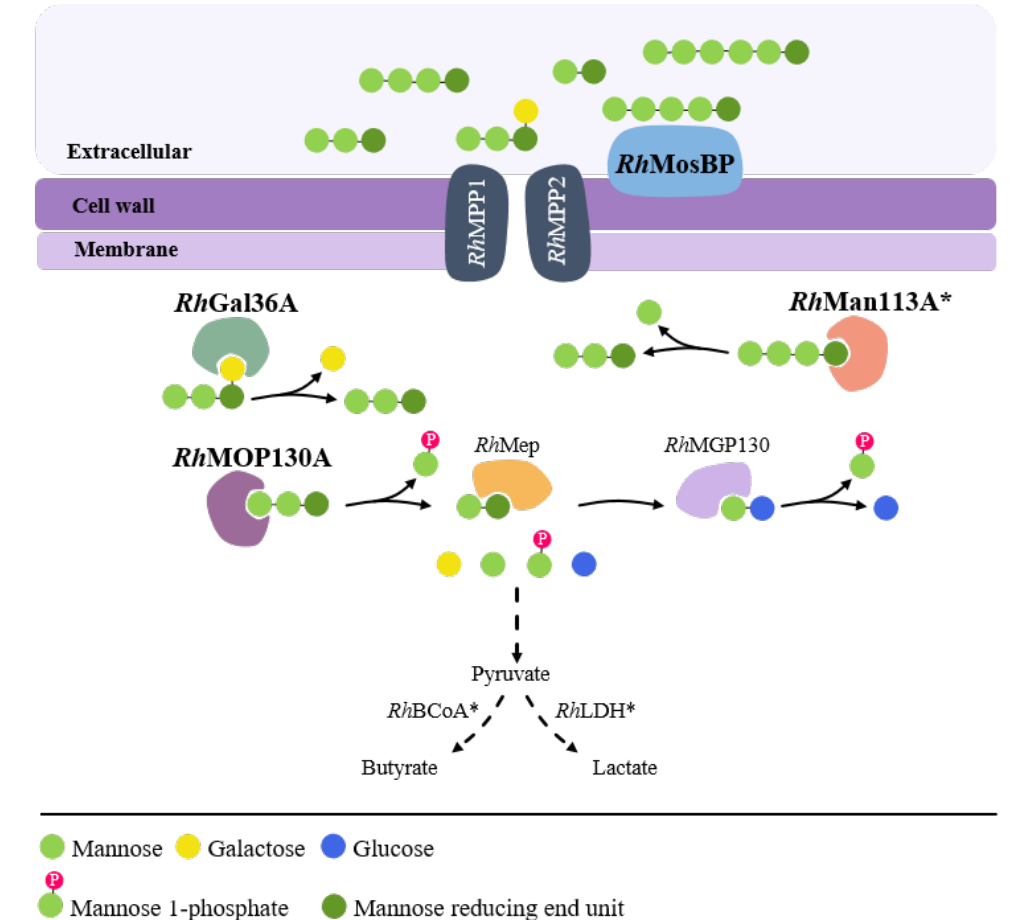
Figure 6. Schematic model of proposed (galactosyl-)mannan-oligosaccharide (MOS/GMOS) utiliza- tion mechanism of R. hominis A2-183. The figure shows a selection of proteins/enzymes proposed to be involved in the uptake and initial degradation of MOS/GMOS. All proteins and enzymes are encoded by the MOS/GMOS utilization locus ( Rh MosUL, RHOM_RS11115-11180), except those marked with an asterisk (*). Gene products for which expression was studied and shown to be upregulated during growth on MOS/GMOS are in black text. Proteins and enzymes that were functionally investigated in this work are highlighted with bold text. The uptake of extracellular mannan-oligosaccharides (mannobiose to mannohexaose) and galactosyl-mannotriose is facilitated by ABC-transporter proteins, here exemplified by the solute-binding protein Rh MosBP and transport proteins (white text, not studied). Based on biochemical data, the α -galactosidase Rh Gal36A removes α -galactosyl substitutions making linear mannan-oligosaccharides available for depolymerization by the exo-oligomannosidase Rh Man113A and the mannan-oligosaccharide phosphorylase Rh MOP130A (phosphoryl shown in red). The dotted arrows illustrate several putative reactions.